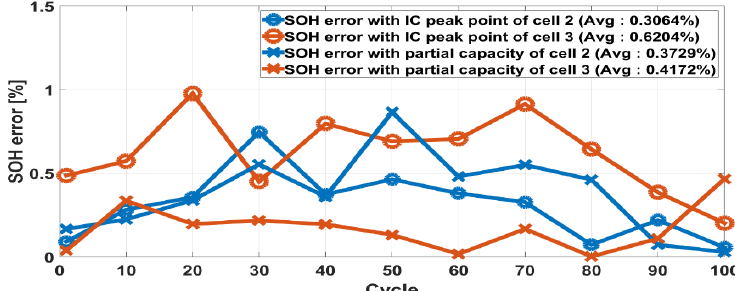
Figure 18. Comparison of four SOH errors (SOH error = Real SOH − Model SOH): (1) between the